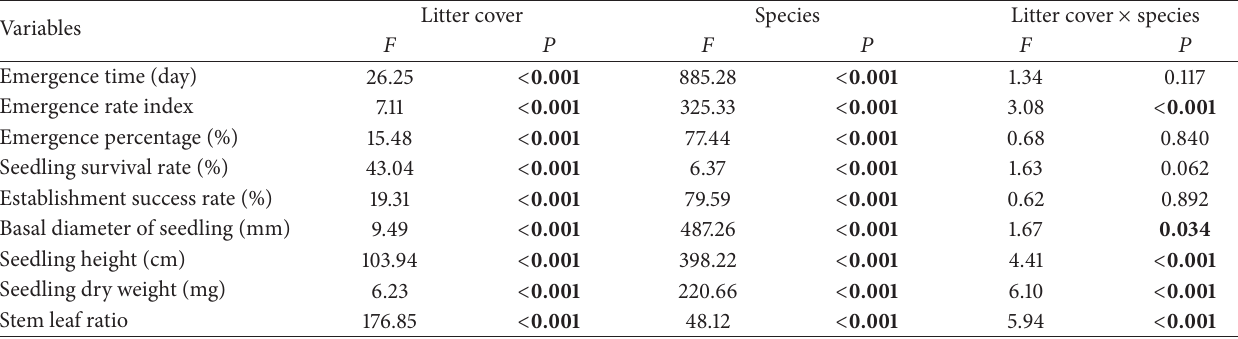
Figure 4: Seedling survival rate (a) and emergence success rate (b) under different species and litter covers. The values were represented as mean + SE; different letters indicate significant difference between treatments at 𝑃 < 0.05 . Table 2: The 𝐹 and 𝑃 values of two-way ANOVA analysis for litter cover, species, and their interactions on seedling emergence, seedling establishment, and seedling